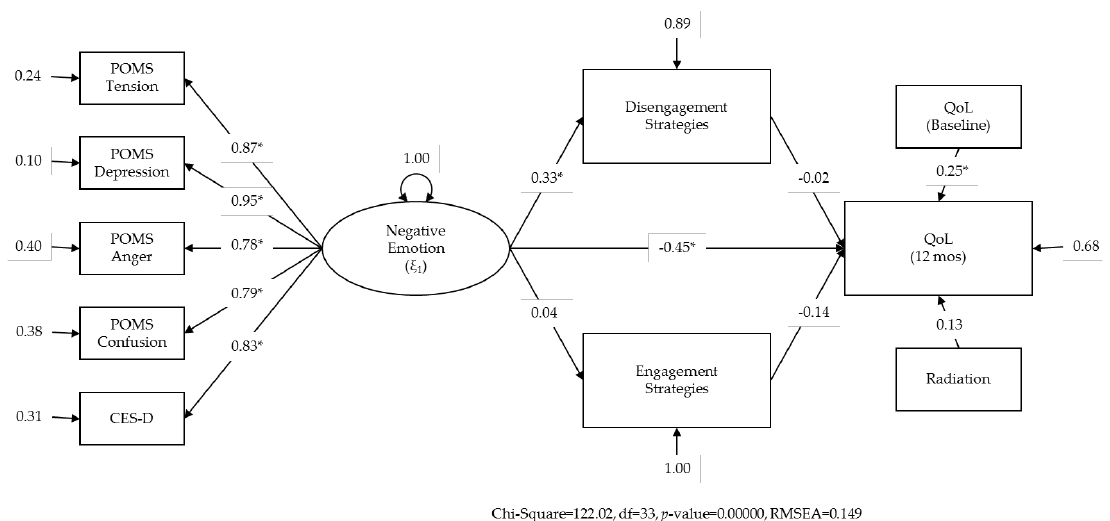
Figure 2. Hypothesized structural equation model testing variable relations that are consistent with parallel mediating effects of engagement and disengagement on the relationship between emotion and quality of life.